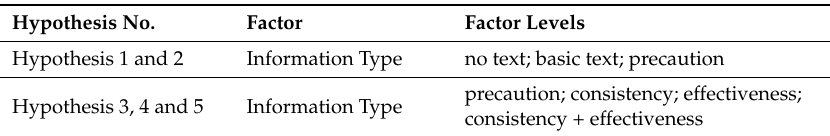
Table 2. Structure of the conducted analyses of variance.